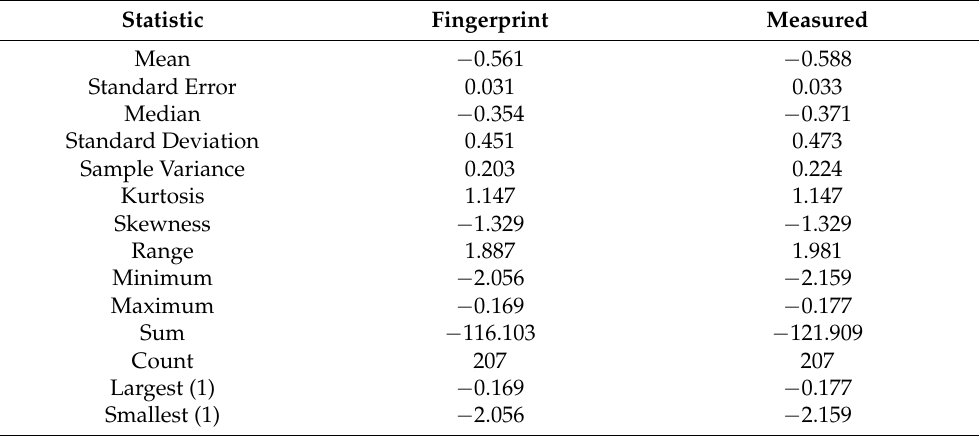
Table 6. Sub-region 2: Descriptive statistics comparison between fingerprint and measured FRA